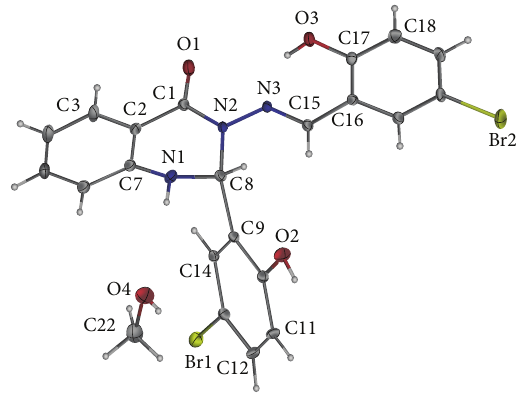
Figure 9: Crystal structure of compound (1).